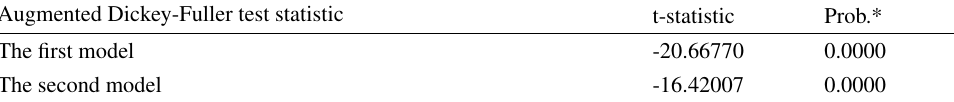
Table 8 Cointegration